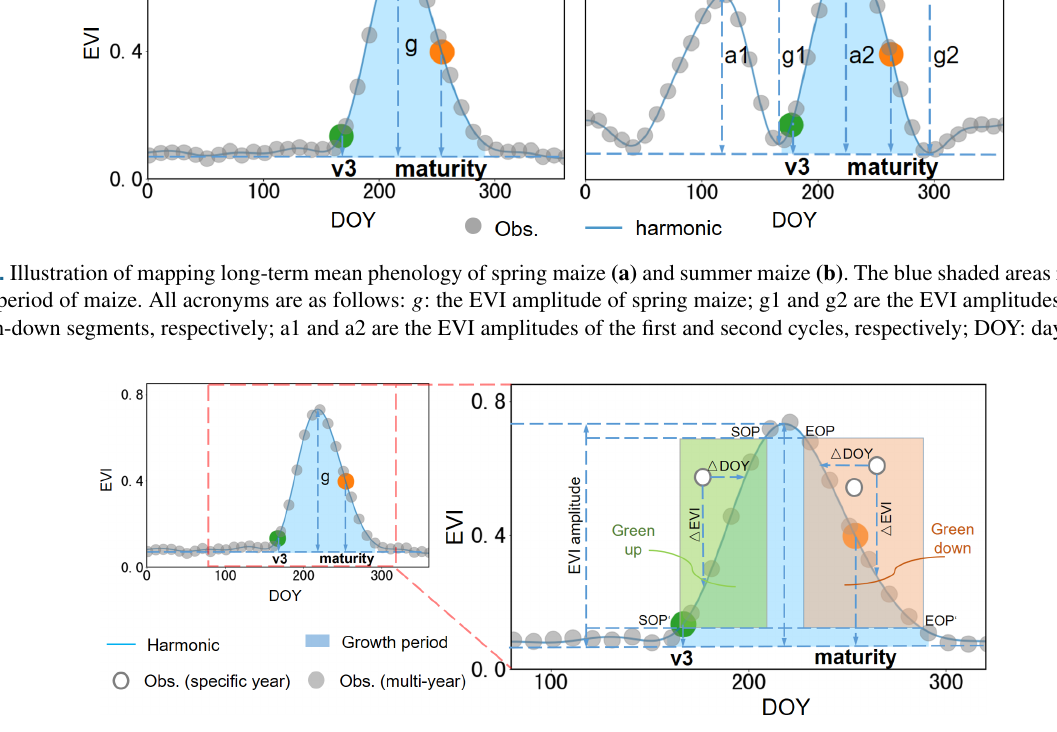
Figure 5. Illustration of detecting annual variabilities of phenological indicators (taking the spring maize as an example). The blue shaded areas represent the growth period of maize. In addition, green and orange shaded areas indicate the reasonable change range of v3 and maturity. The solid and empty circles are long-term and year-specific enhanced vegetation index (EVI) observations. The definitions of all the acronyms are as follows: EOP: end of peak; SOP: start of